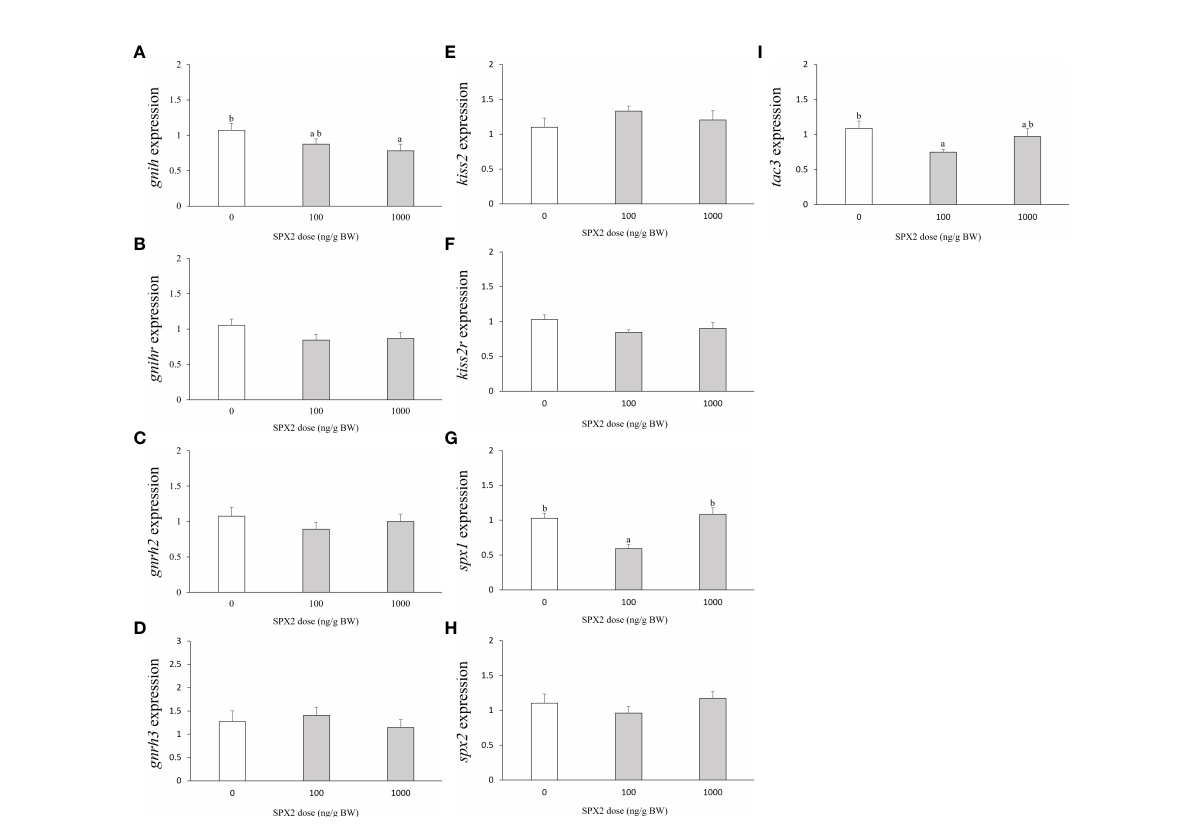
FIGURE 1 Effects of intraperitoneal injection of SXP2 peptide on brain gnih (A) , gnihr (B) , gnrh2 (C) , gnrh3 (D) , kiss2 (E) , kiss2r (F) , spx1 (G) , spx2 (H) and tac3 (I) transcript levels in tongue sole. Data are presented as mean ± SEM (n = 7-8). Different letters indicate signi fi cant differences between groups ( p <